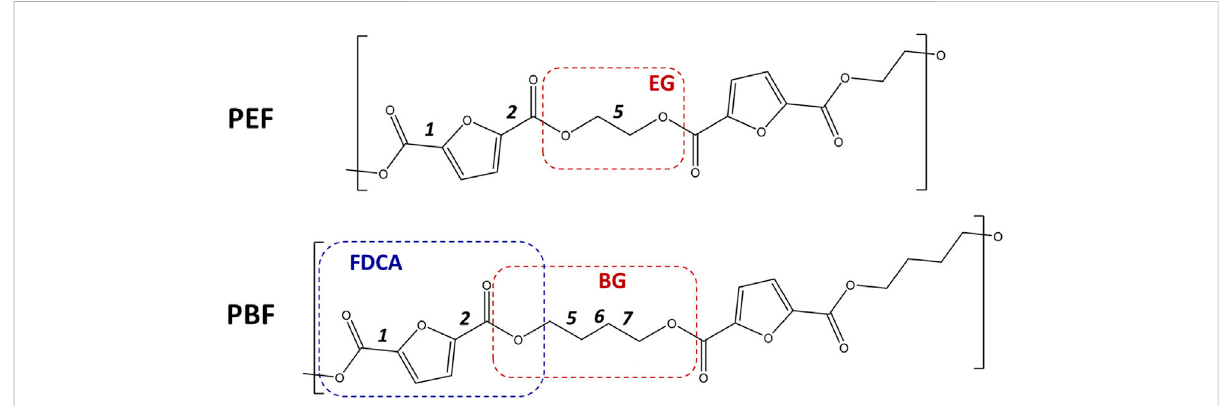
FIGURE 1 Skeletal formulas of the repeating units for poly(ethylene 2,5-furandicarboxylate) ((PEF, top) and poly(butylene 2,5-furandicarboxylate) (PBF, bottom). Dashesdelimitthe1,2-and1,4-alkylglycolmoieties — EG,BG — andthe fi rst 2,5-furandicarboxylicacid moiety – FDCA.The labels1,2, fi veto seven identify the single bonds for which rotational freedom exists. For 1 and 2, the orientation of C=O bonds relative to ring C=C bonds are described as syn or anti . For fi ve EG and 5,6,7 BG bonds, conformations are either trans or gauche. In this way, the PBF structure shown here is described as anti,anti-trans,trans, trans, or aa-ttt for